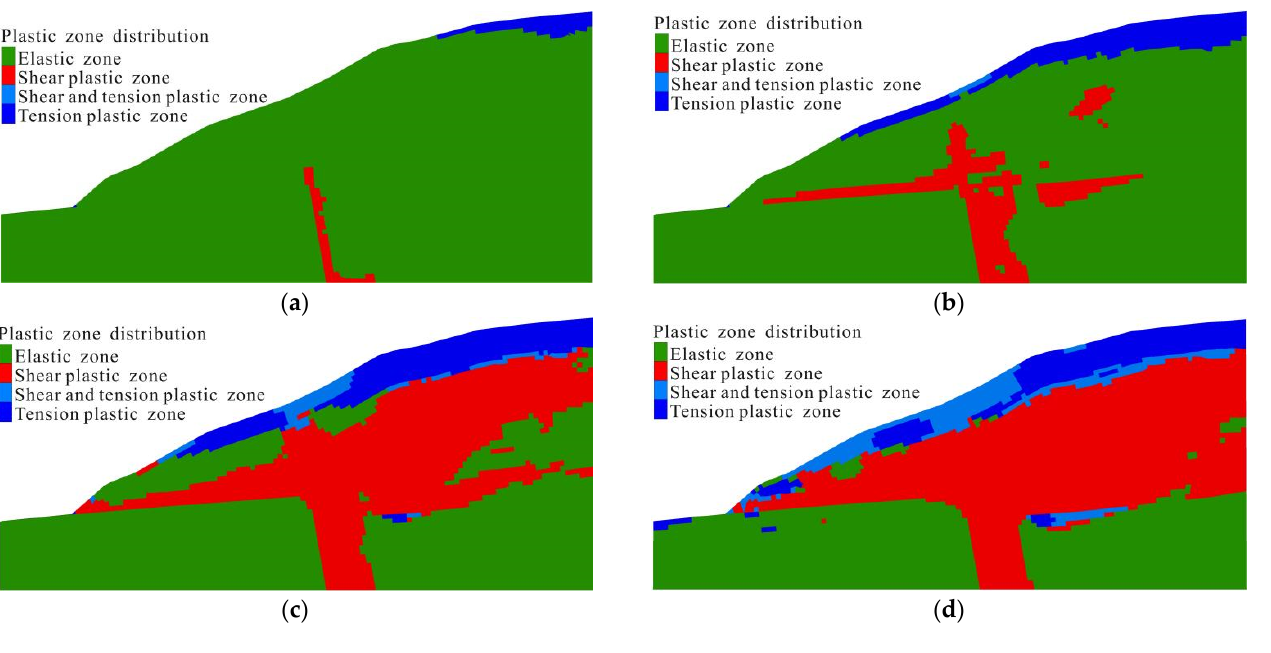
Figure 15. Plastic zone in the model slope with an HADAFZ at input PGA of ( a ) a = 0.1 g, ( b ) a = 0.2 g, ( c ) a = 0.3 g, and ( d ) a = 0.4 g.